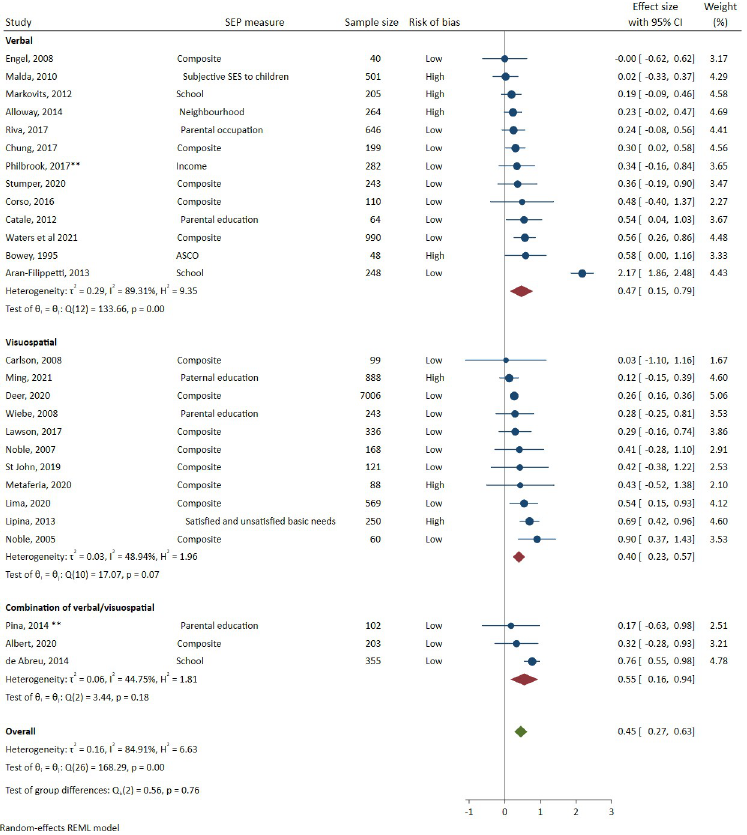
Fig 3. Meta-analysis of the association between socioeconomic position and simple working memory (sorted by effect size). Note: A double asterisk �� indicates a cohort or longitudinal study. Effect sizes to the right of the 0 line favour the higher socioeconomic positioned